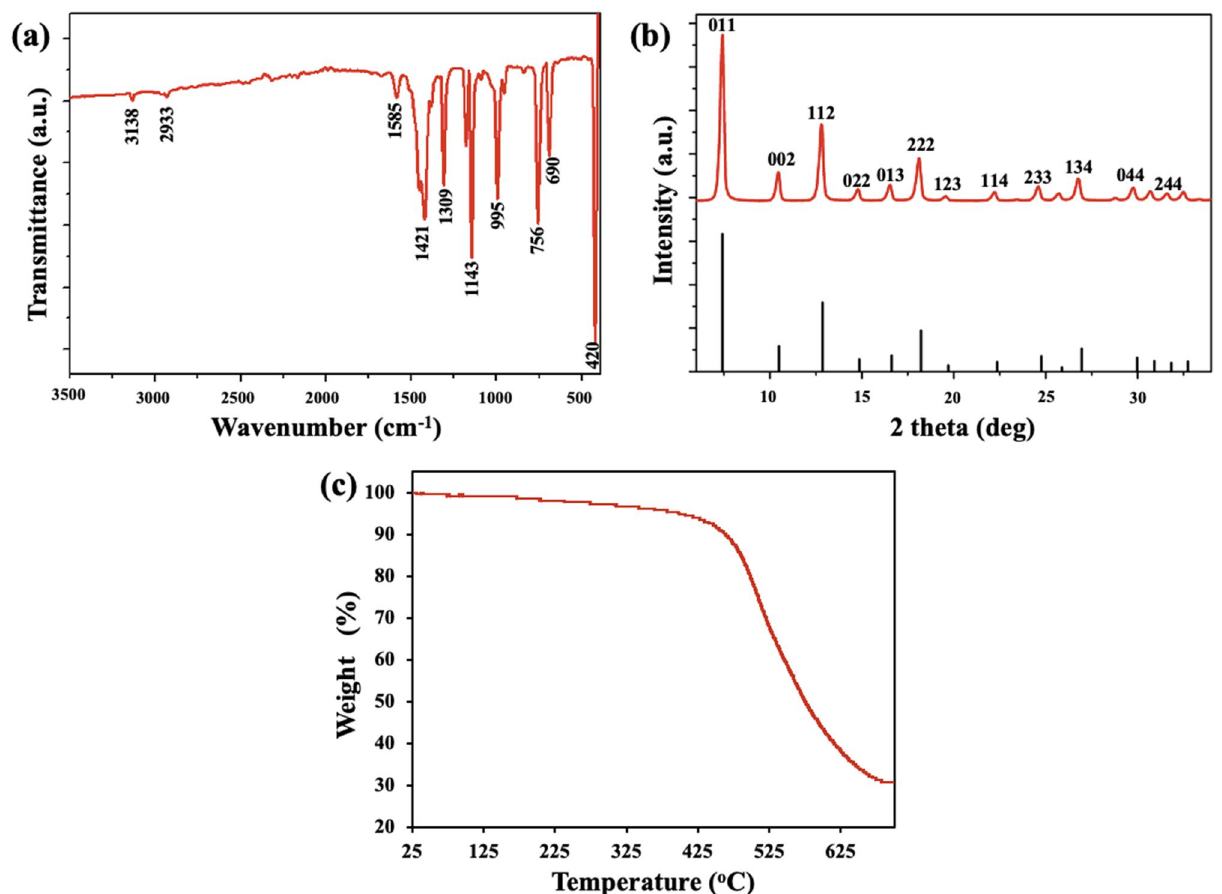
Figure 2. ( a ) FT-IR spectrum of ZIF-8 NPs. ( b ) Powder XRD pattern of ZIF-8 NPs (red) and simulated XRD pattern of ZIF-8 (black, ICDD No.: 00-062-1030). ( c ) TGA